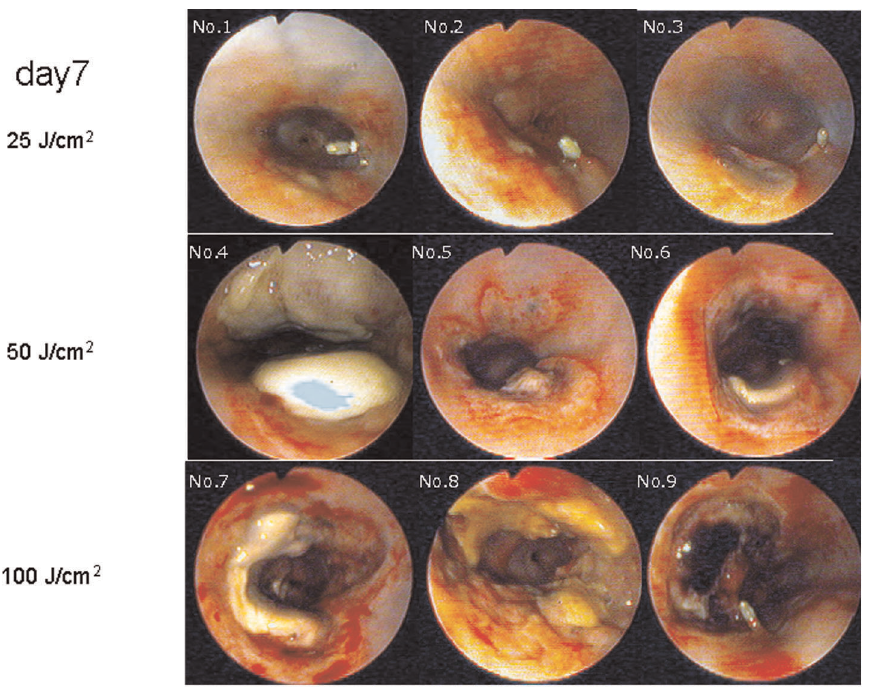
Figure 3. Endoscopic findings in the esophagus on postirradiation day 7. Redness and slight bleeding were observed at the site of irradiation in all dogs on day 7. Ulceration was observed in the 25 J/cm 2 group (A–C) but was more extensive in both the 50 J/cm 2 and 100 J/cm 2 groups (D–I).